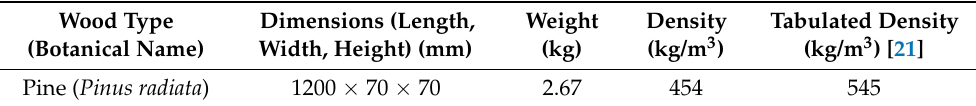
Figure 2. Wood sample: ( a ) the end face of the pine wood sample (70 mm × 70 mm) (Pinus radiata); ( b ) wood sample side view (120 mm × 70 mm). Table 1. Wood sample characteristics with tabulated density measurements for comparison. Wood Type (Botanical